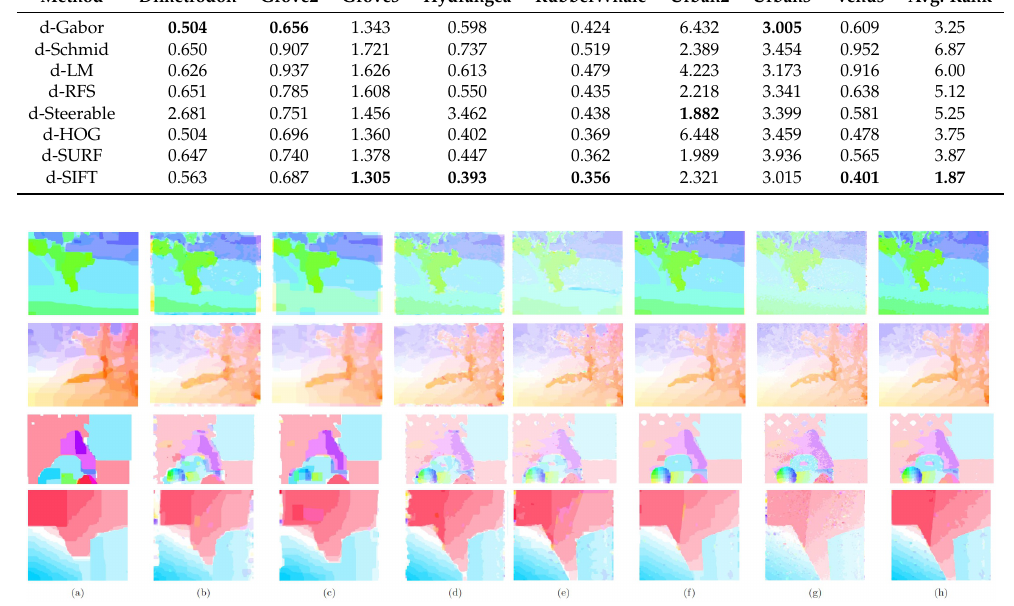
Table 3. Average Endpoint Error (AEE) comparison for training images of the Middlebury dataset. Method